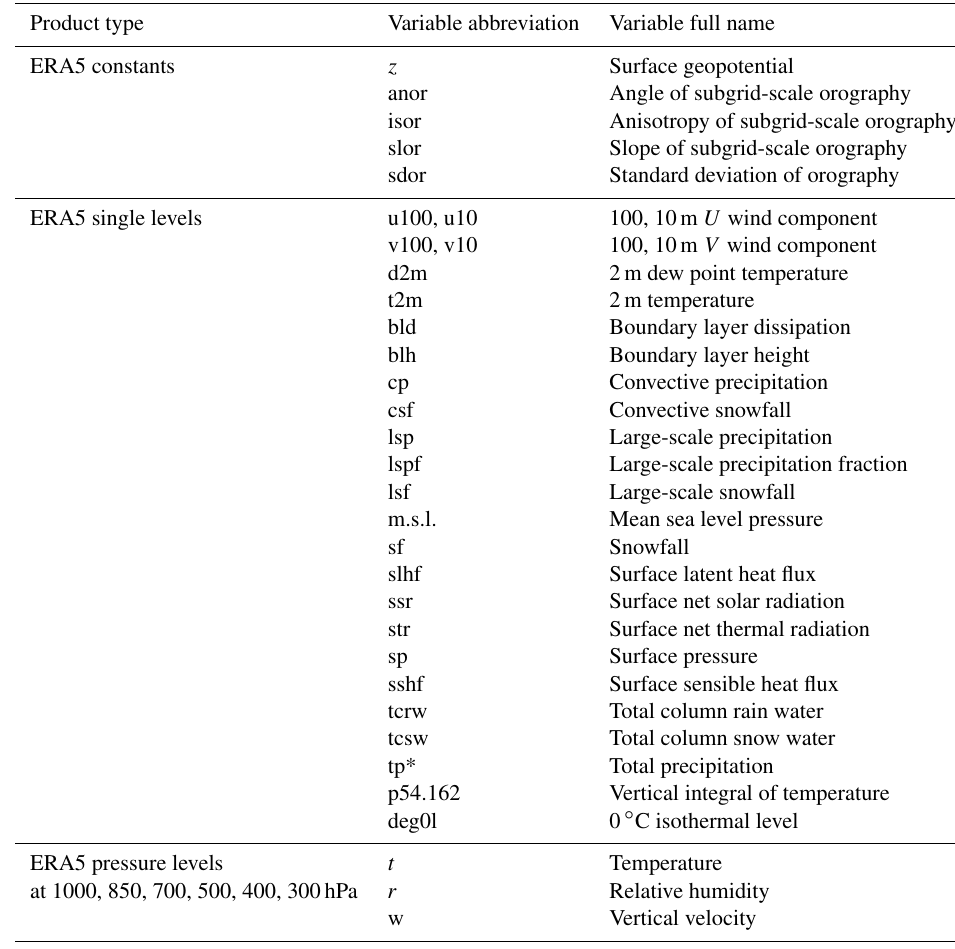
Table B1. ERA5 variables used in the